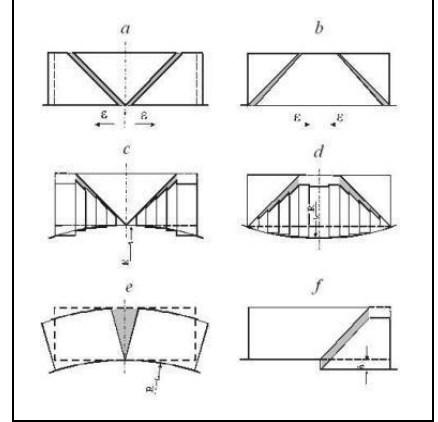
Figure 5. The generalized structural deformations of the walls induced by: a – horizontal shear due to ground surface tension; b – horizontal shear due to the ground surface compression; c – vertical shear due to the curvature of convexity; d – vertical shear due to the curvature of concavity; e – bending due to the curvature of convexity; f – vertical shear due to the bench formation